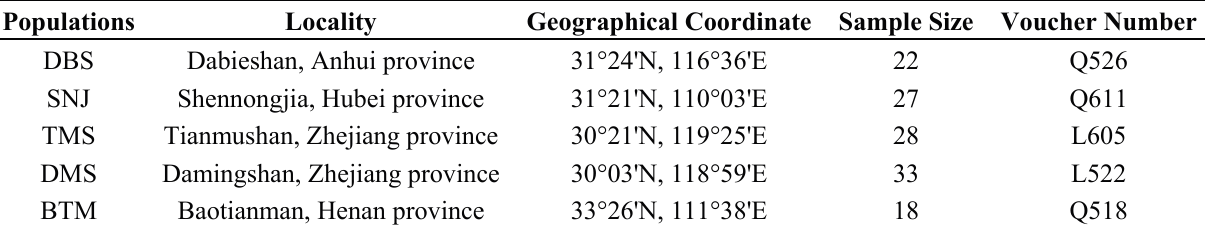
Table 5. Sampling details of the C. japonicum